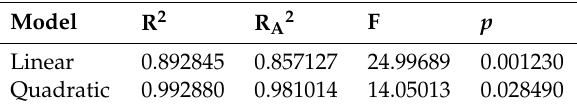
Table 5. Analysis of variance (ANOVA) of the linear and quadratic models for a contact angle with 95% confidence level.